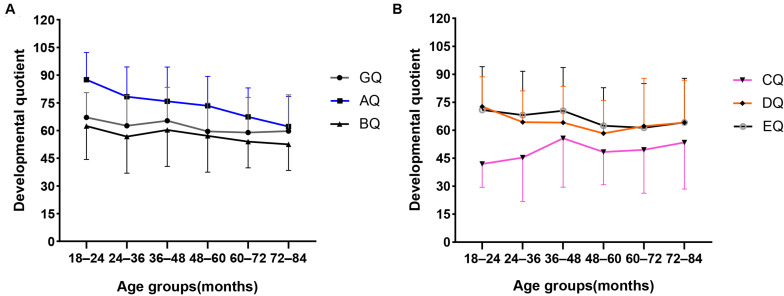
Mean scores distribution of the GQ and A–E subscale quotients in different age groups. (A) Mean scores distribution of the GQ, AQ, and BQ in different age groups. (B) Mean scores distribution of the CQ, DQ, and EQ in different age groups. Standard deviations of the mean are represented in the figure by the error bars attached to each line.